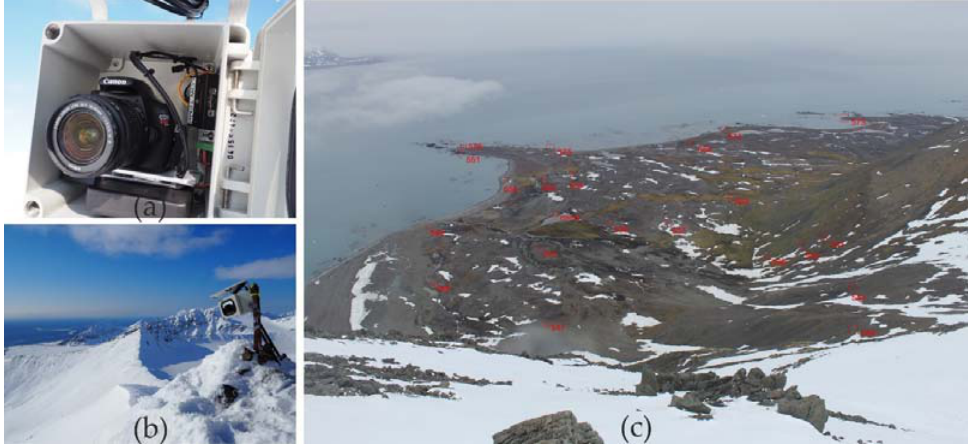
Figure 2. Time-lapse camera set: ( a ) Internal view; ( b ) Placement near the Fugleberget summit; ( c ) View from the camera (16 June 2016) with marked location of all the Ground Control Points (GCP) used in the orthorectification process.